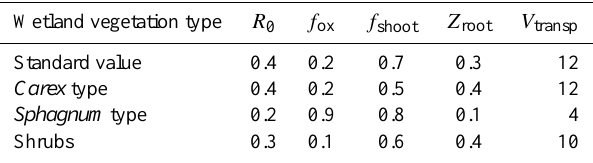
Table 3. Standard and PFT adapted values for vegetation param- eters. The standard parameter values are used for runs when no vegetation distinction is made, as in Berrittella and van Huisste- den (2009). Parameter symbols as in Table 2, Wetland PFT’s as in Table